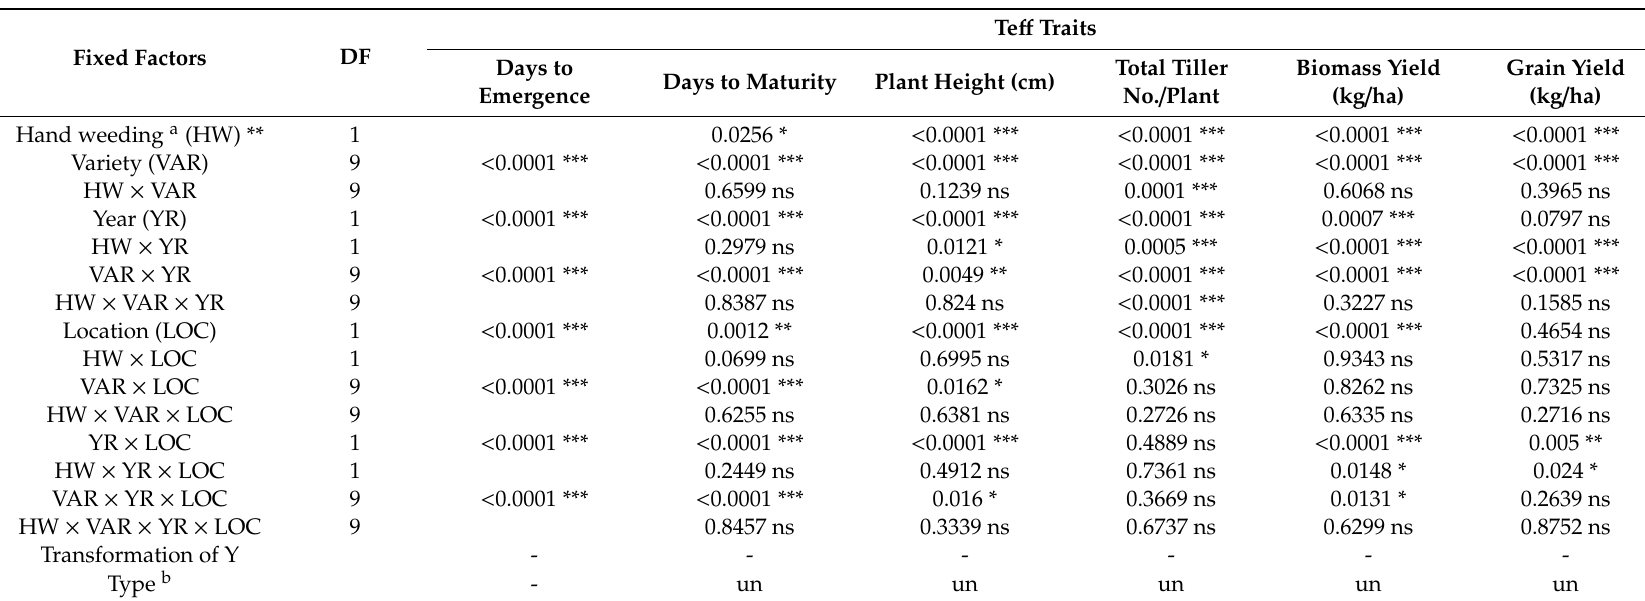
Table 4. ANOVA table with P-values for the main factors hand weeding, te ff variety, year, and location, and their interactions on di ff erent te ff traits.